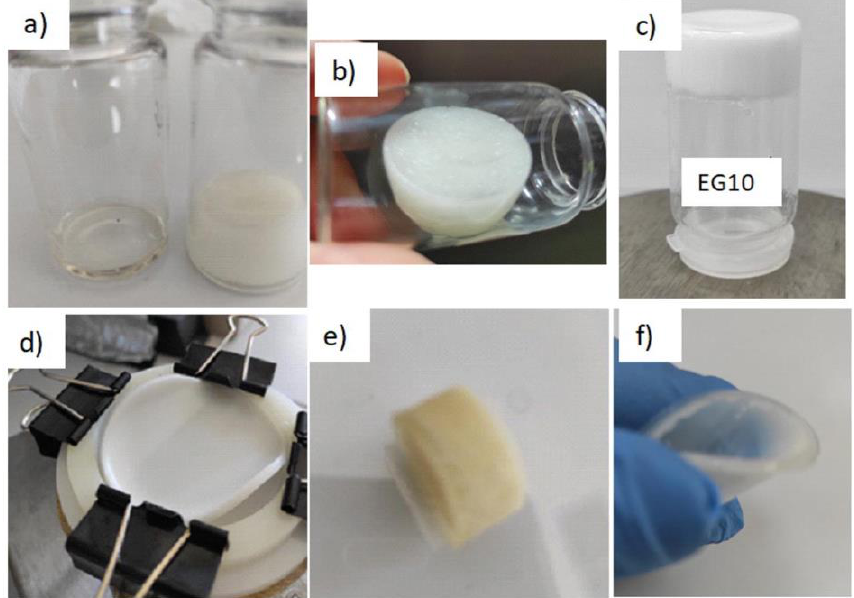
Figure 5. Silicone emulsion gels with 33% or 50% water phase: ( a ) comparison between the amount of silicone used and the corresponding gel; ( b , c ) swollen gels; ( d ) swollen film just after UV irradiation; ( e ) dried monolith; ( f ) flexible dried film. Gels 2022 , 8 , x FOR PEER REVIEW